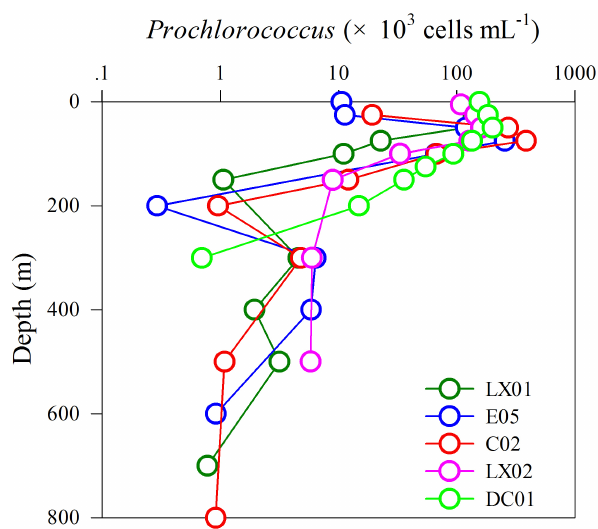
Fig. 2. Depth profile of abundance of Prochlorococcus in the Lu- zon Strait area, showing the presence of Prochlorococcus (10 2 – 10 4 cellsml − 1 ) in the aphotic waters (below 200m).